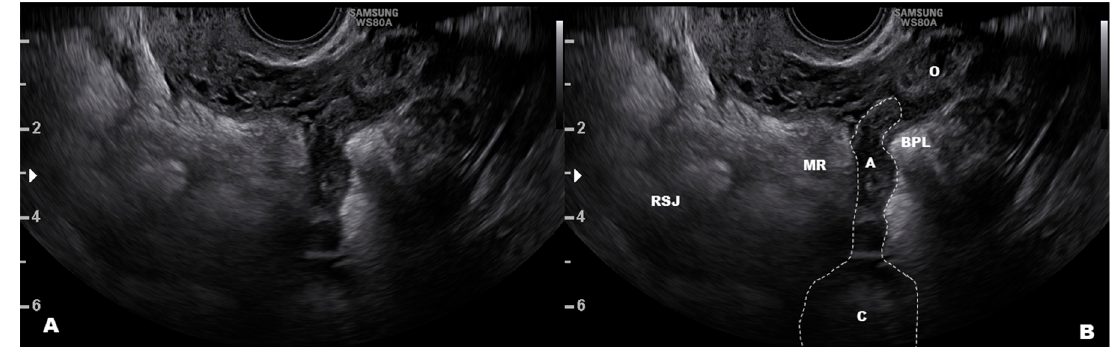
Figure 4. Appendix dislocated downward and attached to the ovary that may mimic mesorectal endometriosis. ( A , B ) show the clean and the labelled image. Abbreviations: A, appendix; O, Ovary; BPL, broad posterior ligament; C, caecum; MR, mesorectum; RSJ, rectosigmoid junction.